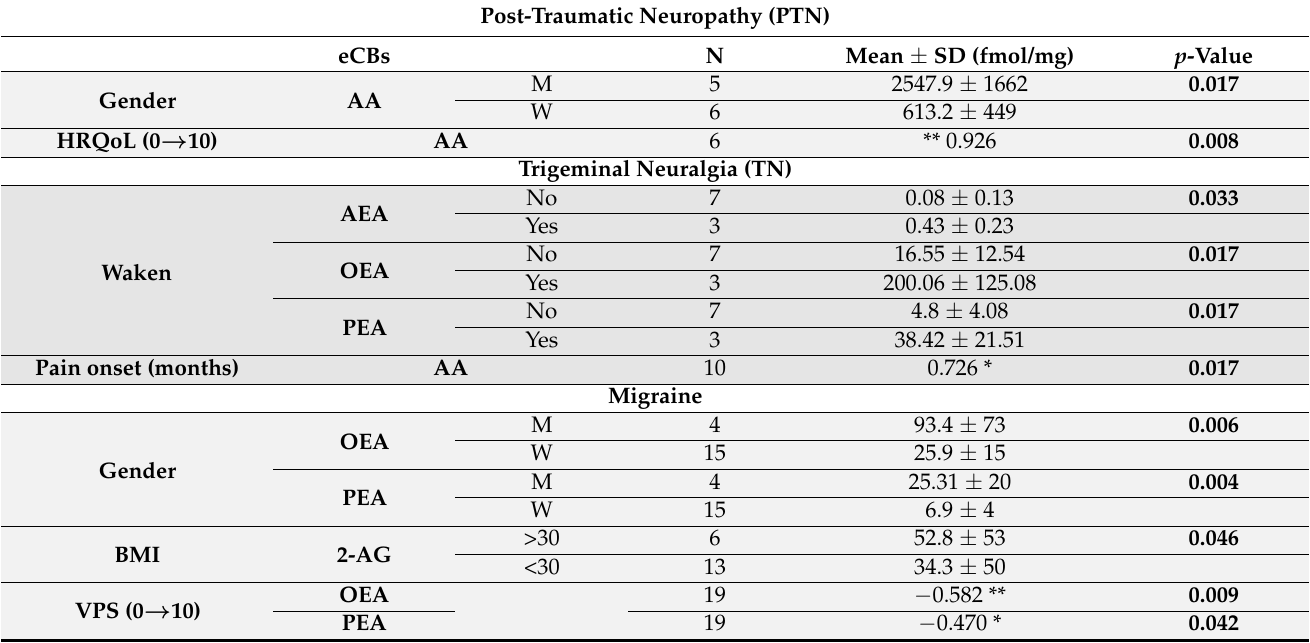
Table 3. Patient and pain characteristics in relation to eCB levels for PTN, TN, and